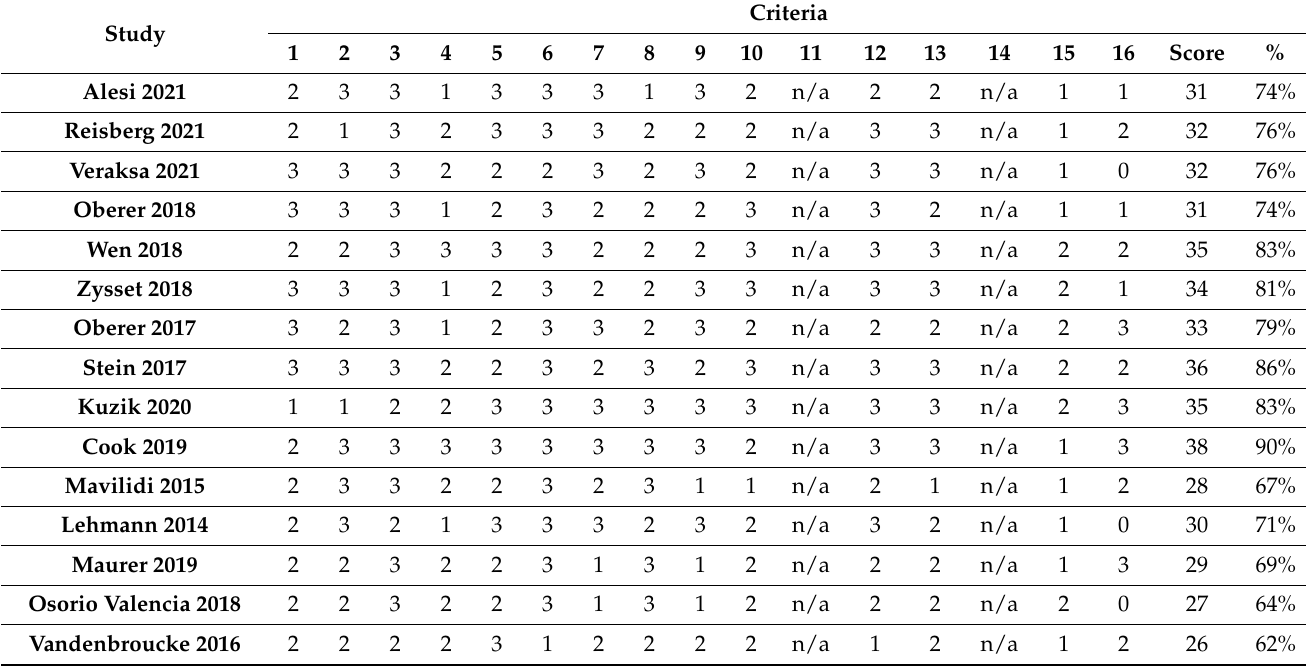
Table 2. Methodological quality appraisal according to the QATSDD.